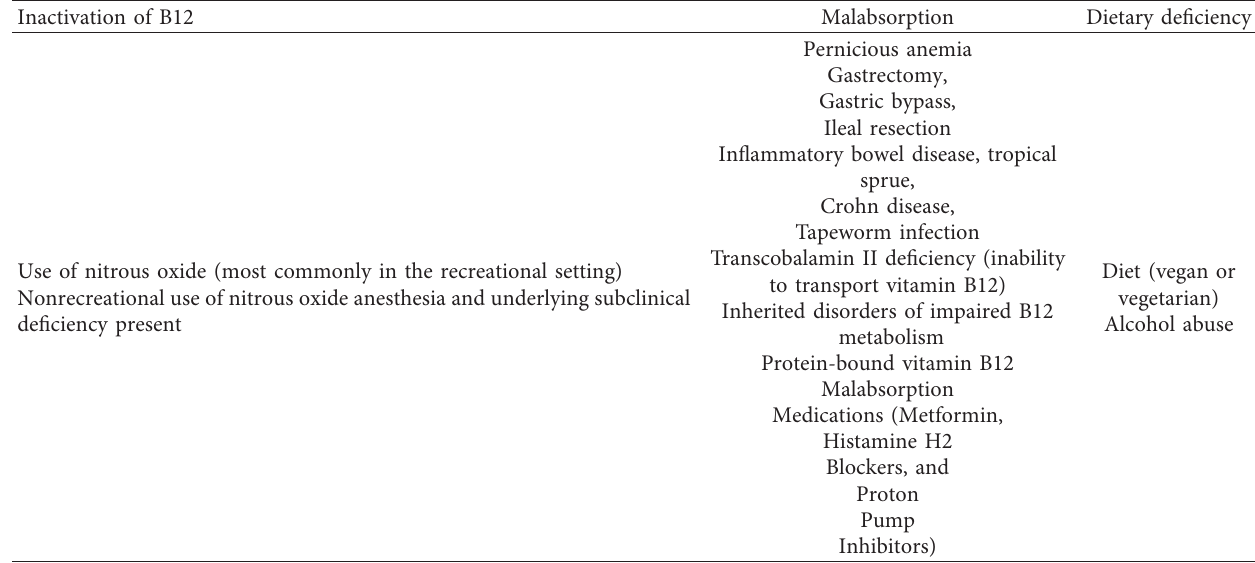
Table 2: Causes of vitamin B12 deficiency; representation of the exhaustive causes of hypovitaminosis B12 categorized by inactivation, malabsorption, and dietary deficiency.